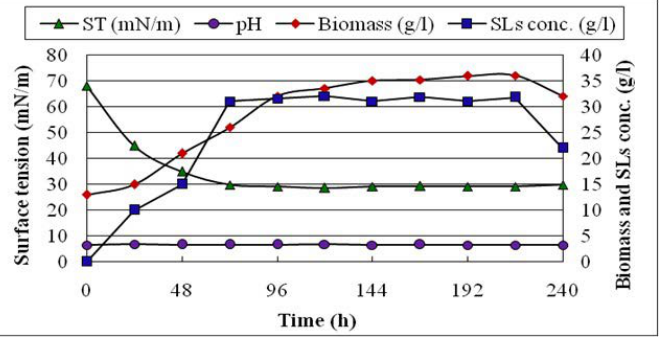
Fig. 1a – 1b. Phylogenetic tree of Candida tropicalis RA1 and its related sequences retrieved from NCBI.